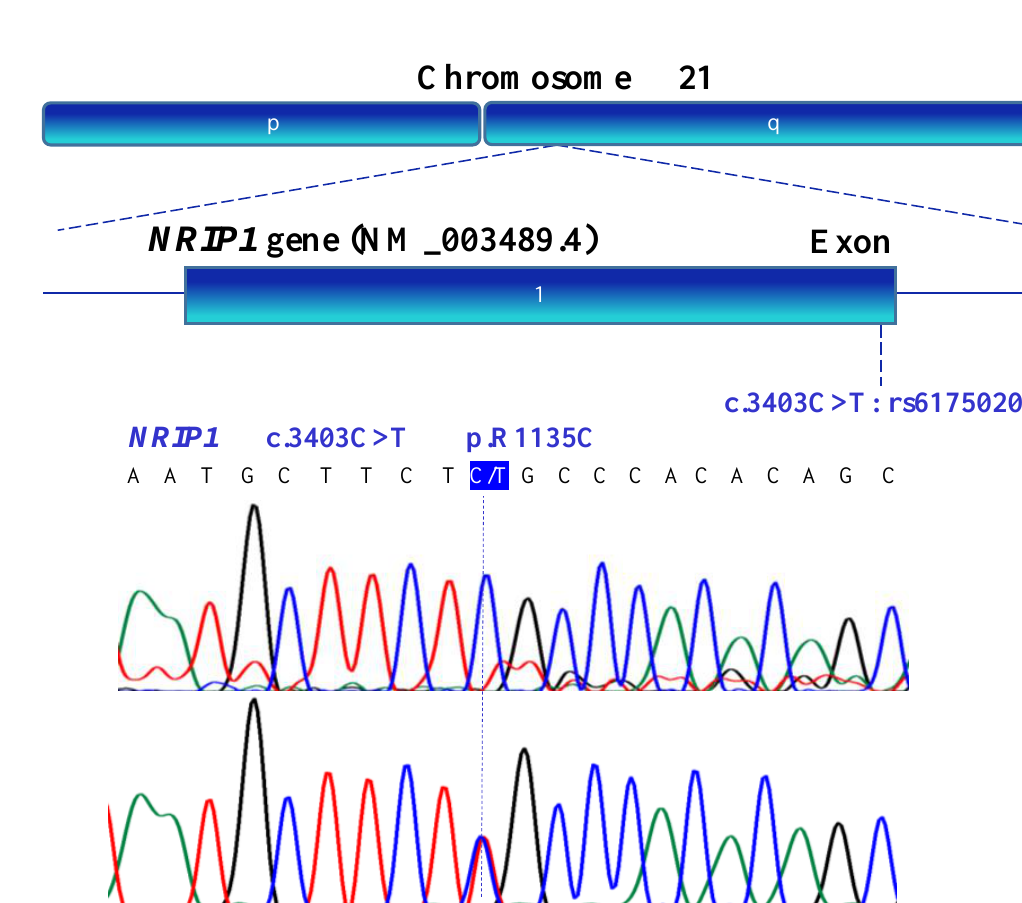
Figure 8. Exonic region of the human NRIP1 (NM_003489.4) gene located on the long arm of chromosome 21. Nucleotide sequence analysis identified a polymorphic variant located in the end region of the intronless NRIP1 gene (blue box). Table 1. A summary of the genotype and allele frequencies for the WT1 (NM_024426.6),